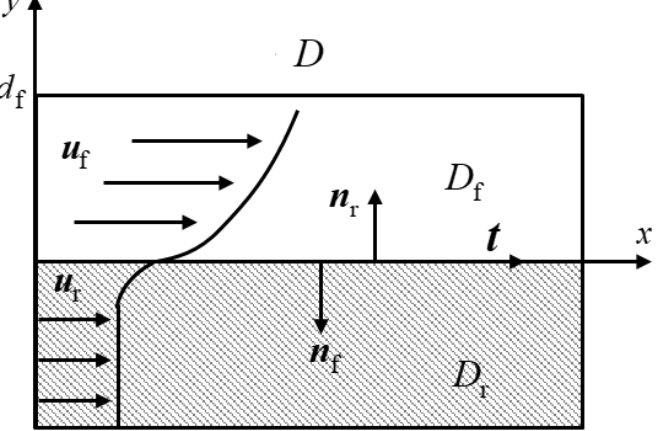
Figure 1. Schematic of Darcy – Stokes problem [33,41]. Subdivision of the domain D into a free-flow subregion D f and a porous medium subdomain D r by an internal interface Γ r − f